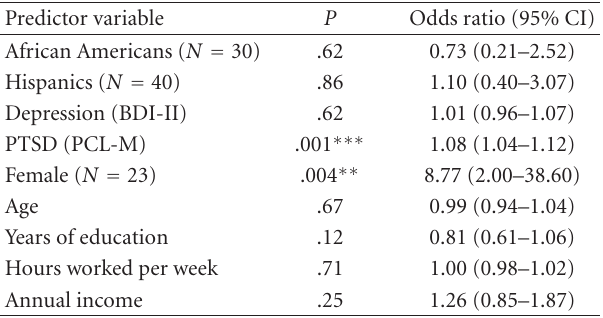
Table 5: Logistic regression predicting medication treatment.